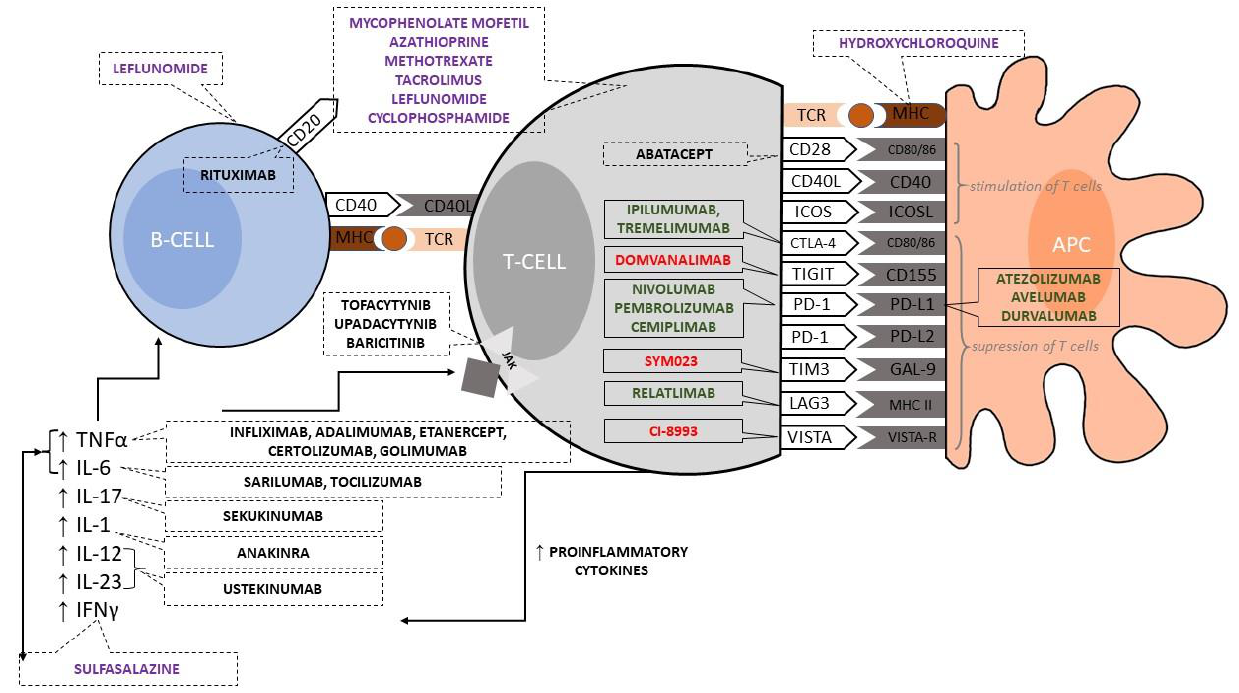
Figure 1. Immunological synapse with stimulatory/inhibitory receptors and interactions between immune cells. Checkpoint inhibitory agents (in a solid line frame) registered by European Medicines Agency and/or U.S. Food and Drug Administration are presented (in green color) with examples of molecules that are currently under evaluation in clinical trials (in red color). Two signals are required to induce T-cell response: (1) presentation of the antigen bound to major histocompatibility complex (MHC) on the antigen-presenting cell (APC) surface followed by its recognition by the specific T-cell receptor (TCR) (left-hand side), and (2) cluster of differentiation (CD) 28 and CD80/CD86 interaction — second stimulating signal (right-hand side). Ligands on APCs (stimulatory/inhibitor receptors) determine the response of T cells. With immune checkpoint inhibitors, activated T cells release inflammatory cytokines that act against malignant cells and can cause immune-related adverse events as an off-target effect. The presented mechanisms of immunosuppressive agents (in a dotted line frame) are simplified. Classic immunosuppressive/immunomodulatory agents are in violet. New medications with more precise, tailored action modes, such as biologics or tyrosine kinase inhibitors, are in black. They are registered in rheumatic diseases but can also be used to manage rheumatic immunologic-related adverse events of immunologic checkpoint inhibitors in oncology. Abbreviations: APC — antigen-presenting cell, CD — cluster of differentiation,